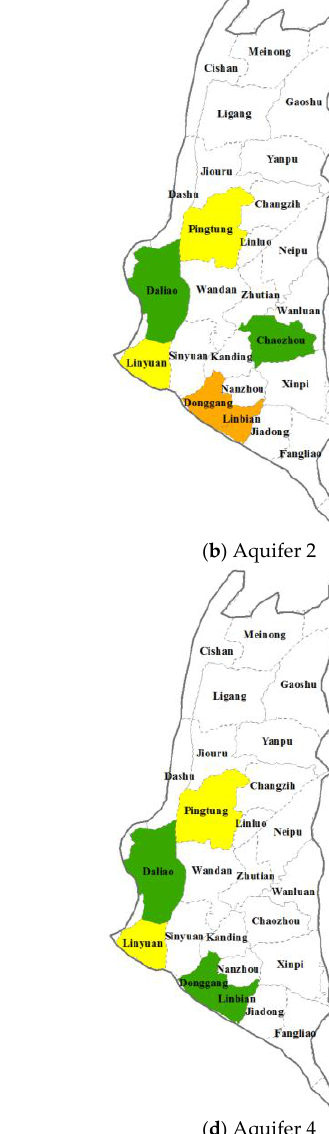
Figure 8. Zonal risk calculated based on target cancer risk (TR) and population density.